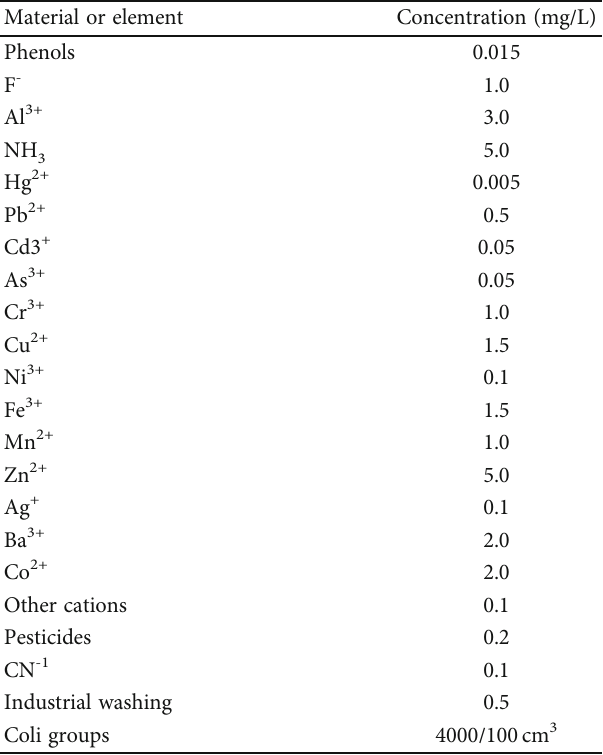
Figure 1: (a) The preparation of the PANI/Ag electrochemical PowerStation and a xenon lamp. Table 1: The chemical composition of the sewage water-electrolyte for H 2